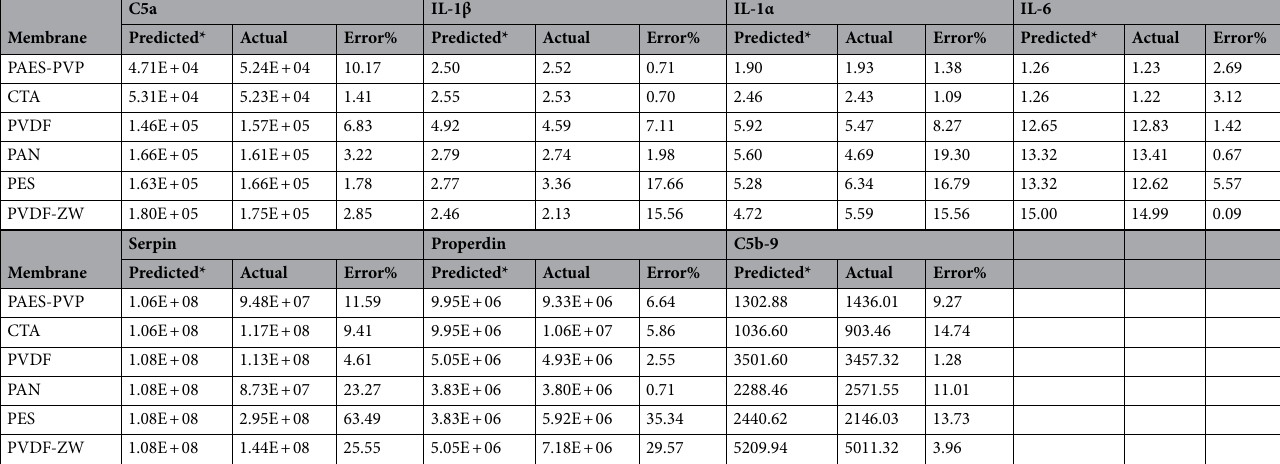
Table 4. Predicted [obtained from Eqs. (49–56), and correction factors from Table 2] vs. actual for different materials. *Predicted values obtained with the affinity-based model (Eqs. 49–56). Similar results are obtained if any of the models are used within the experimental range defined. The responses obtained using different models differ between 0 and 2% on